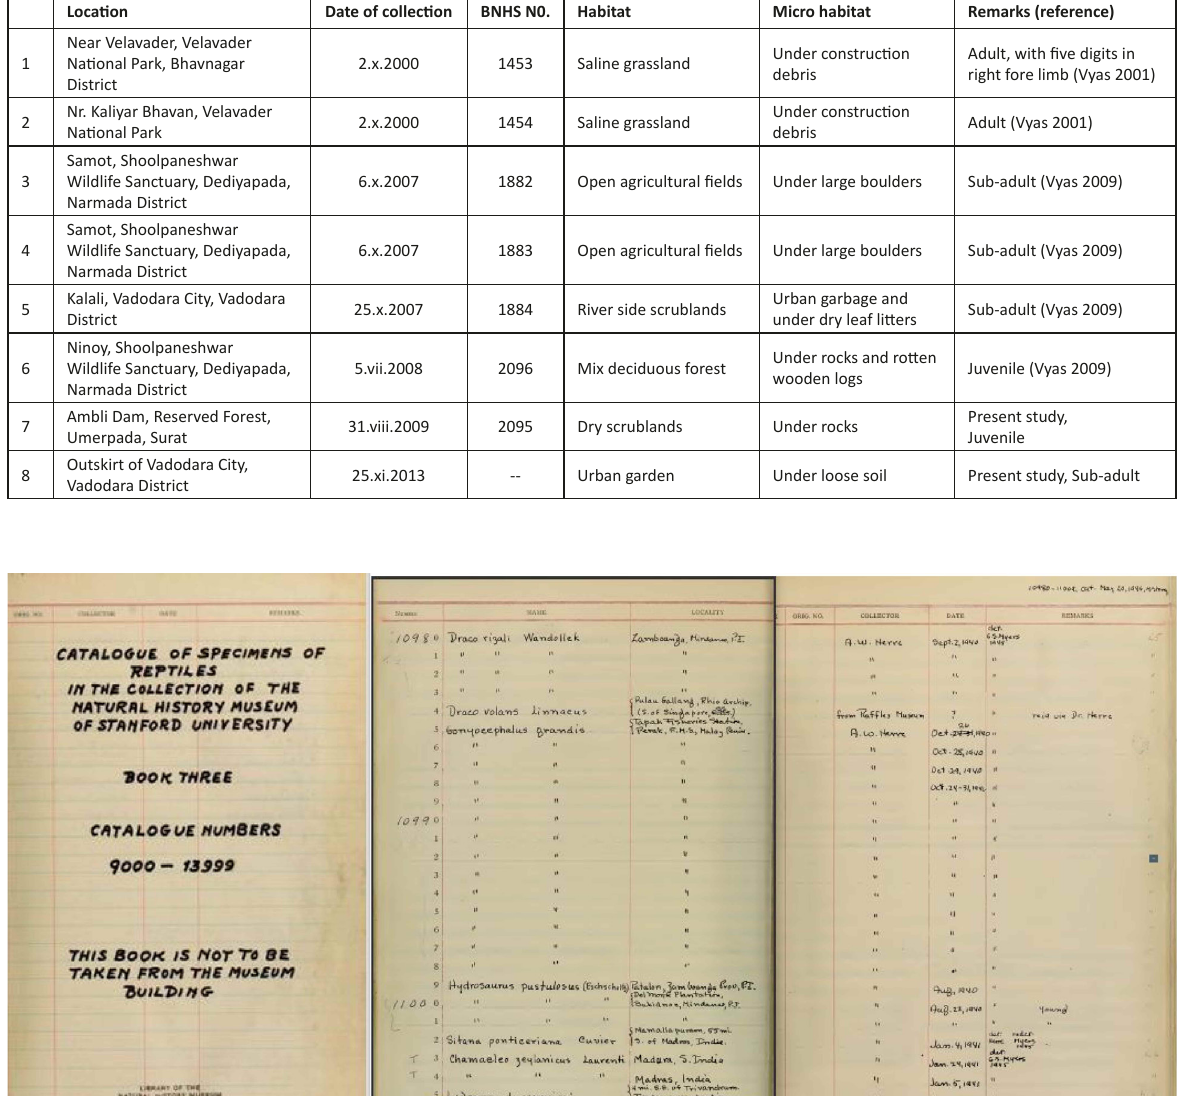
Table 2. Details of specimens of Lygosoma lineata collected and examined from Gujarat State, India